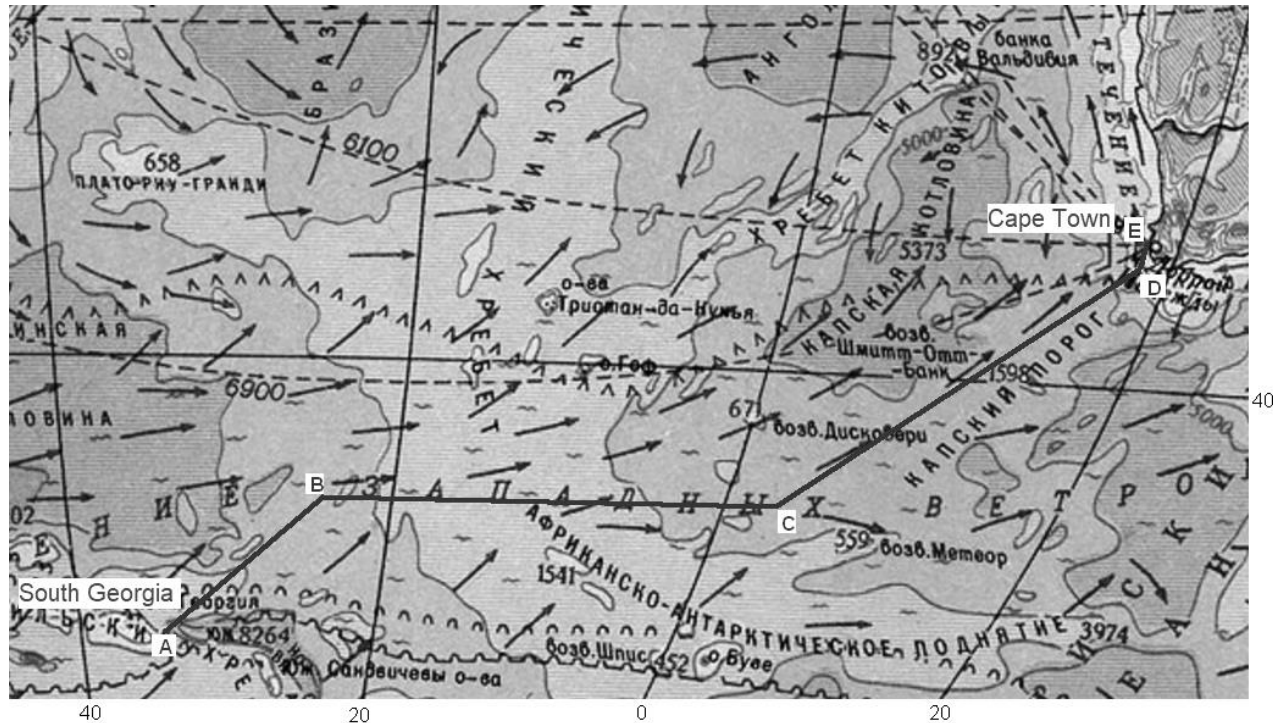
Figure 4. The sections of selected iceberg transport route (own elaboration based on [59]). Selected climate assumptions for the respective sections of the route are presented in Table 3. Taking into account the initial results of transport time calculations, the temperature assumptions for the A–C route sections were adopted for the August–November period, and the C–E sections, for the November–January